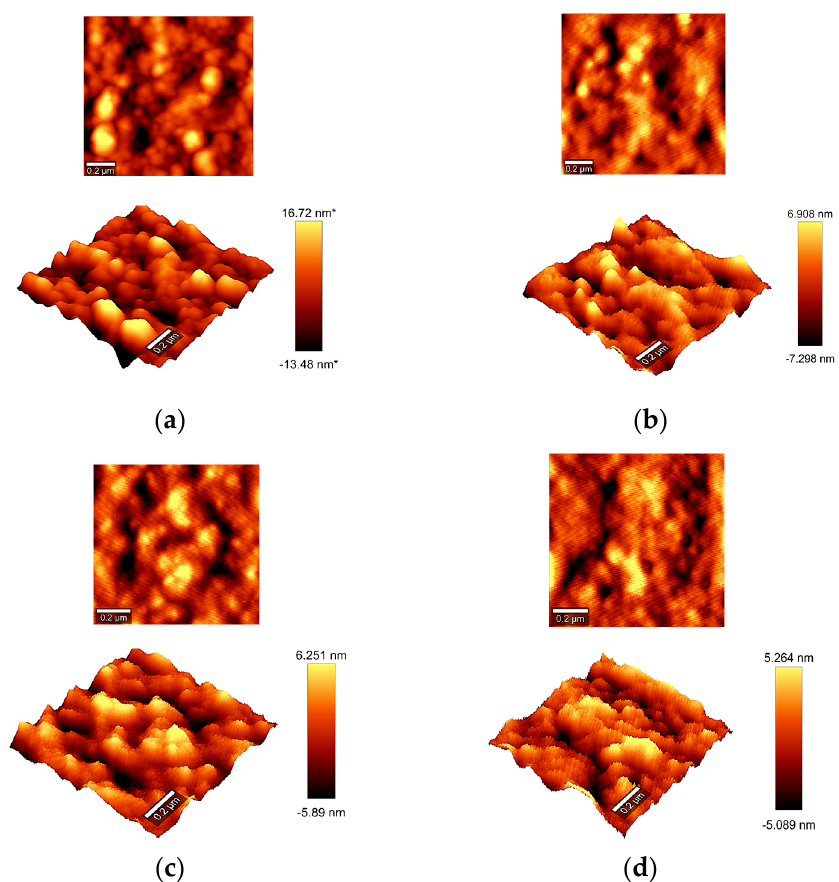
Figure 7. AFM topography images of thermally treated IPCP-A samples (heated and suddenly cooled in salted ice water ( − 10 °C)): ( a ) nontreated; ( b ) 135 °C; ( c ) 165 °C; ( d ) 190 °C.